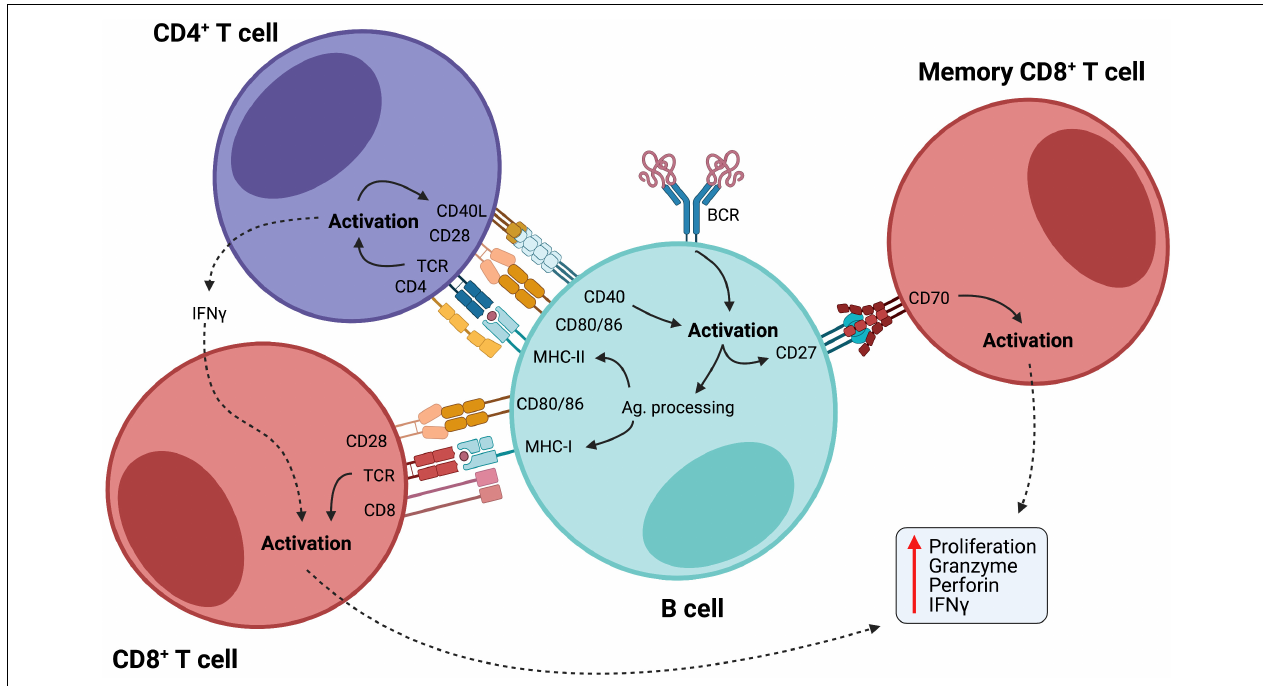
FIGURE 1 | B cells as activators of cellular immunity. B cells are initially activated by antigen recognition through BCR. Internalized antigens are then presented through class II MHC to CD4 + helper T cells, which provide co-stimulatory signals for B cell activation. Activated B cells acquire enhanced potential for antigen presentation with upregulation of MHC-I and II and co-stimulatory molecules, such as CD80/86, further activating both CD4 + and CD8 + T cells. Also, CD27 is upregulated in activated B cells, and interaction between this molecule and CD70 on the membrane of memory CD8 + T cells promotes their maintenance and facilitates their activation in an antigen-independent manner. CD8 + T cell activation leads to efficient cell proliferation and production of potent inflammatory mediators, such as granzymes, perforin, and IFN- γ